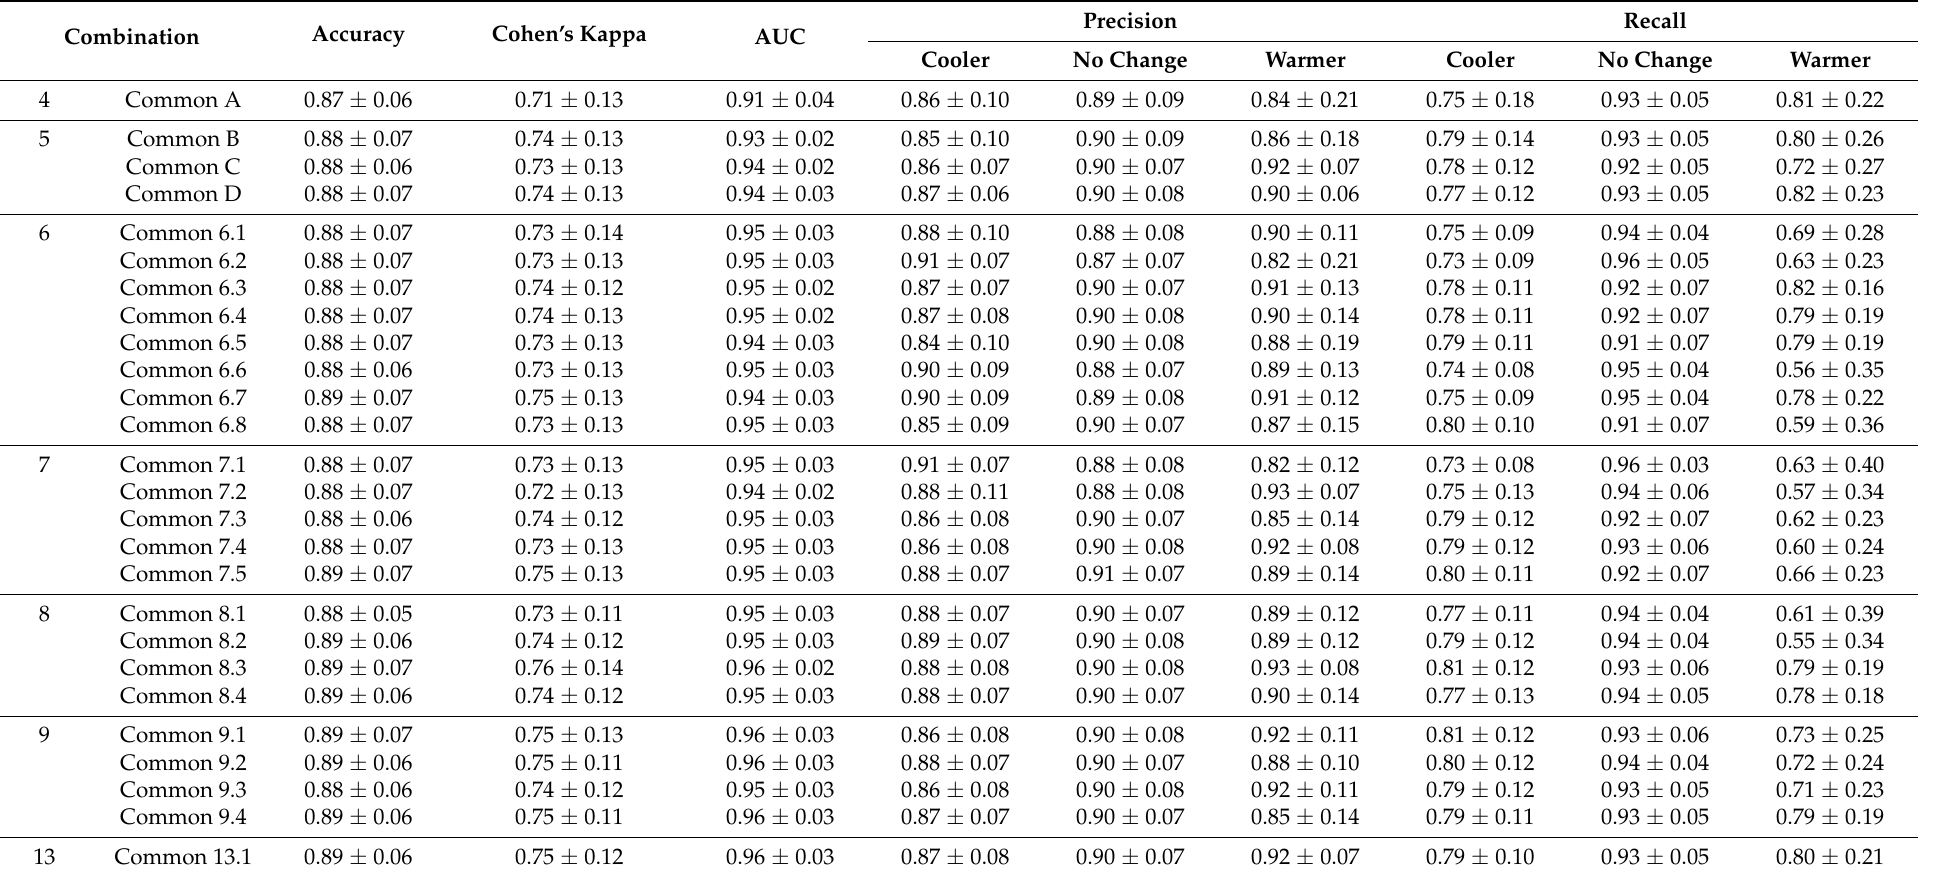
Table A3. Subject-averaged prediction power of 26 commonly used